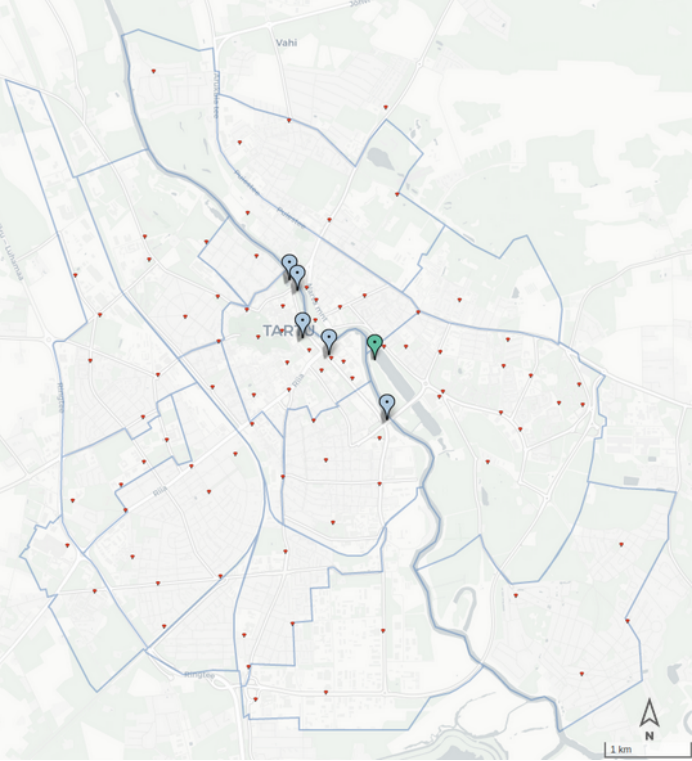
Figure 4. Data collection points for bike package: Thinnect sensors (blue), ECO sensor (green), and location of Tartu Smart Bike stations